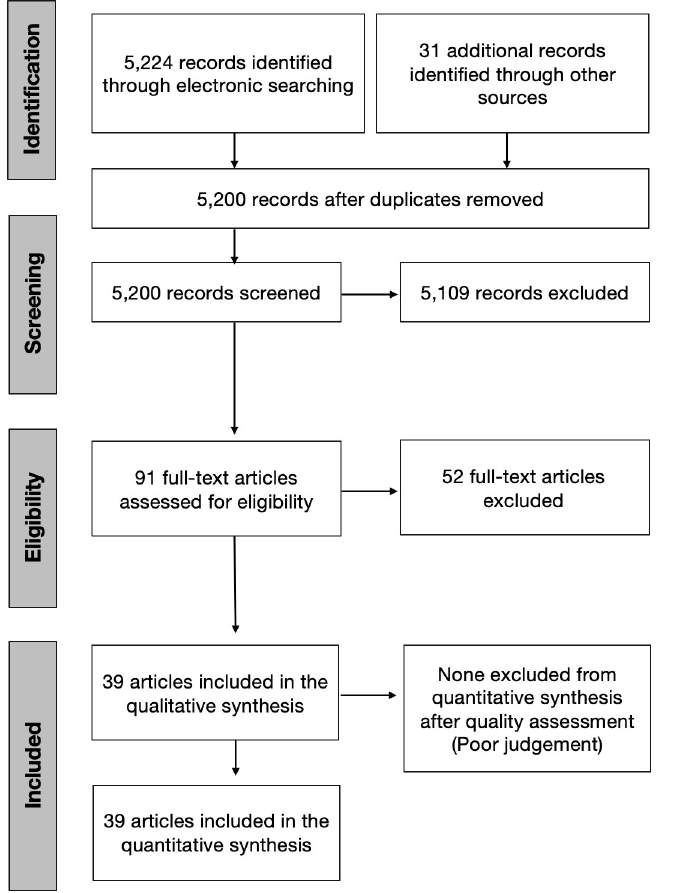
Fig 1. The review search and selection